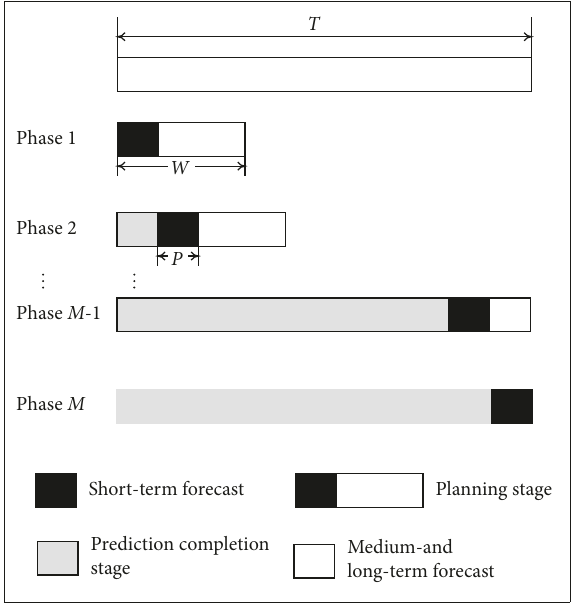
Figure 2: Rolling time-domain